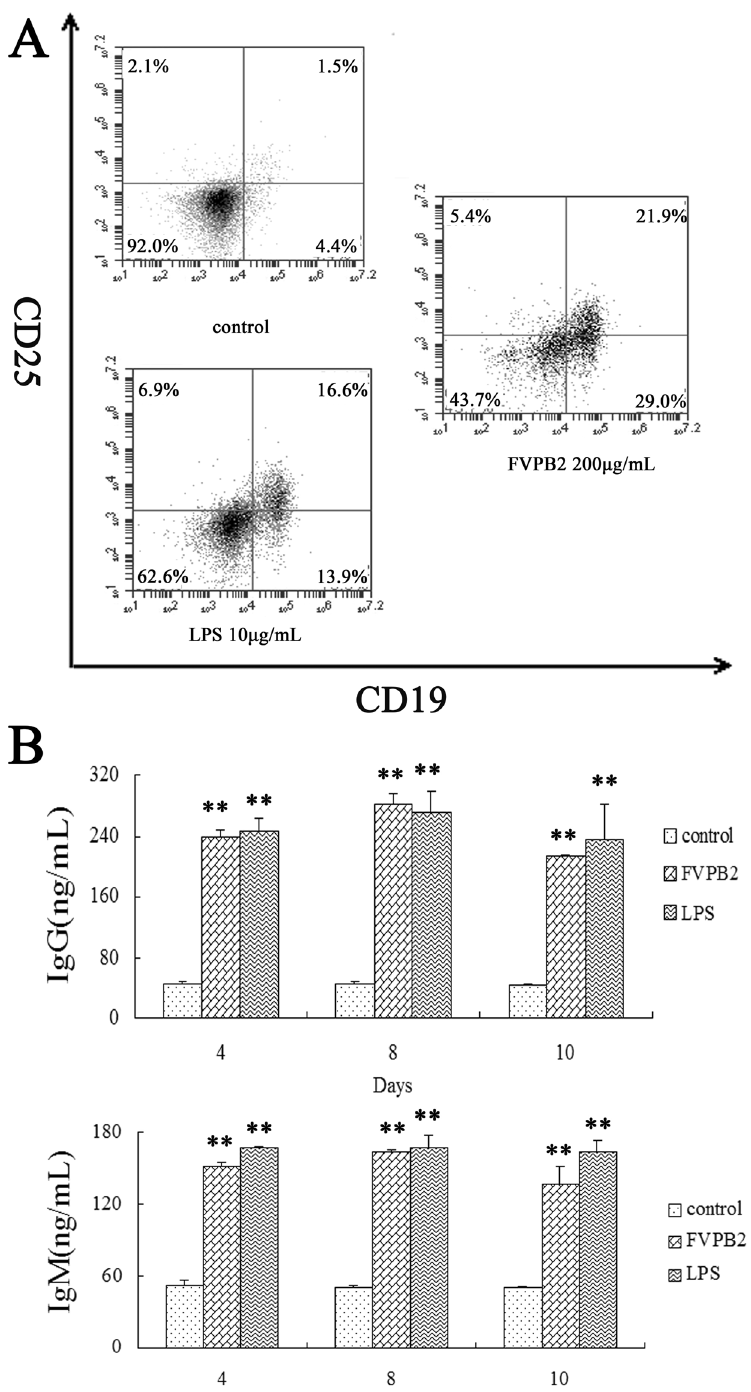
Figure 6. Activation of B cells isolated from mouse spleen lymphocytes treated by FVPB2. ( A ) Expression level of CD19 and CD25 on purified B cells, which were treated by 200 μ g/mL FVPB2, 10 μ g/mL LPS, or PBS for 48 h as analyzed by FACS. ( B ) Secretion of IgG and IgM by purified B cells treated with FVPB2. Purified B cells were incubated with 200 μ g/mL FVPB2, 10 μ g/mL LPS or PBS as control. Each value represents the mean ± SD of separate triplicate experiments. Values significantly higher than those of the controls are indicated by * P < 0.05 and ** P <